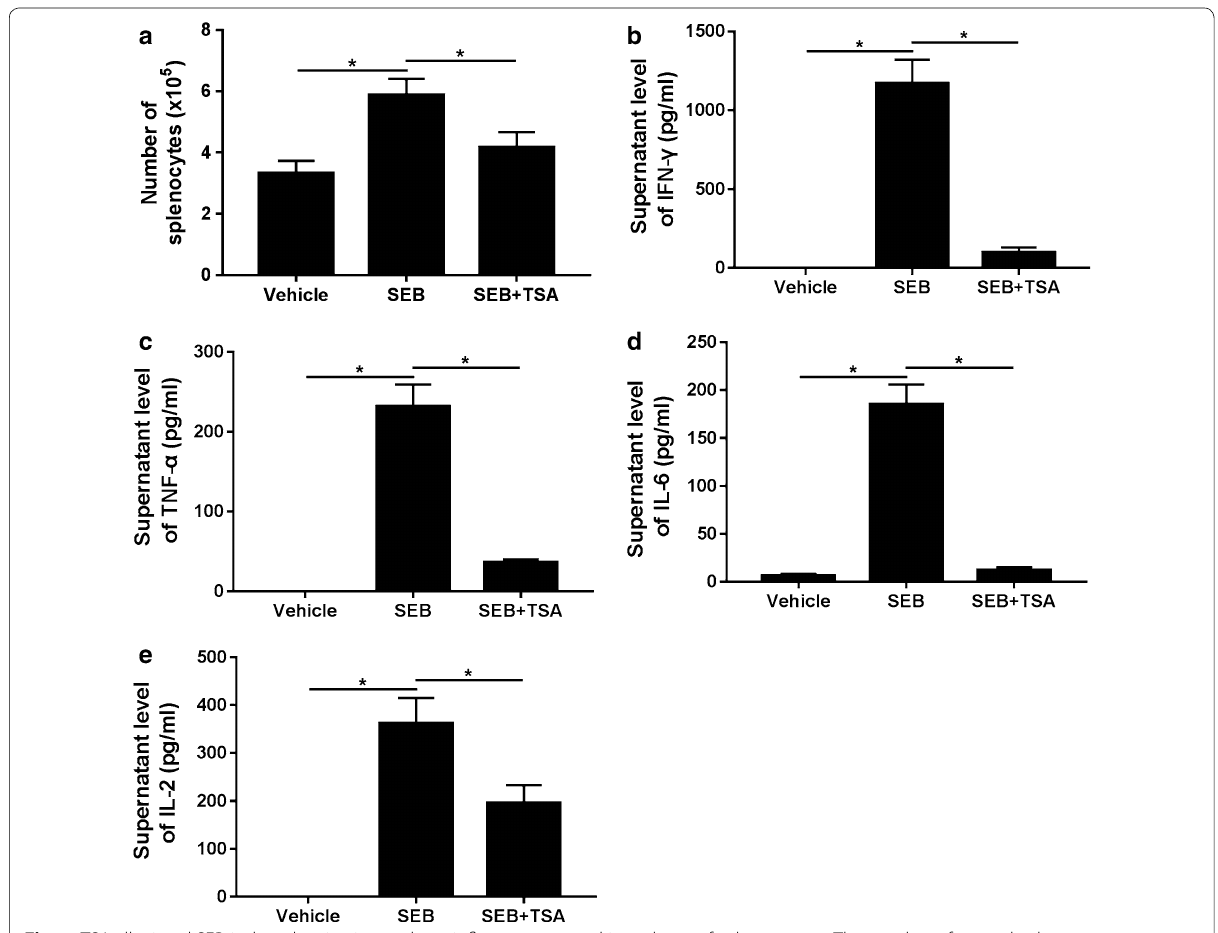
Fig. 5 TSA alleviated SEB-induced activation and pro-inflammatory cytokine release of splenocytes. a The number of treated splenocytes was analyzed by flow cytometry analysis. b The protein expressions of IFN-γ, TNF-α c , IL-6 d and IL-2 e in the supernatants of the treated splenocytes were measured by ELISA. * P < 0.05. SEB group versus Vehicle or SEB TSA group, +